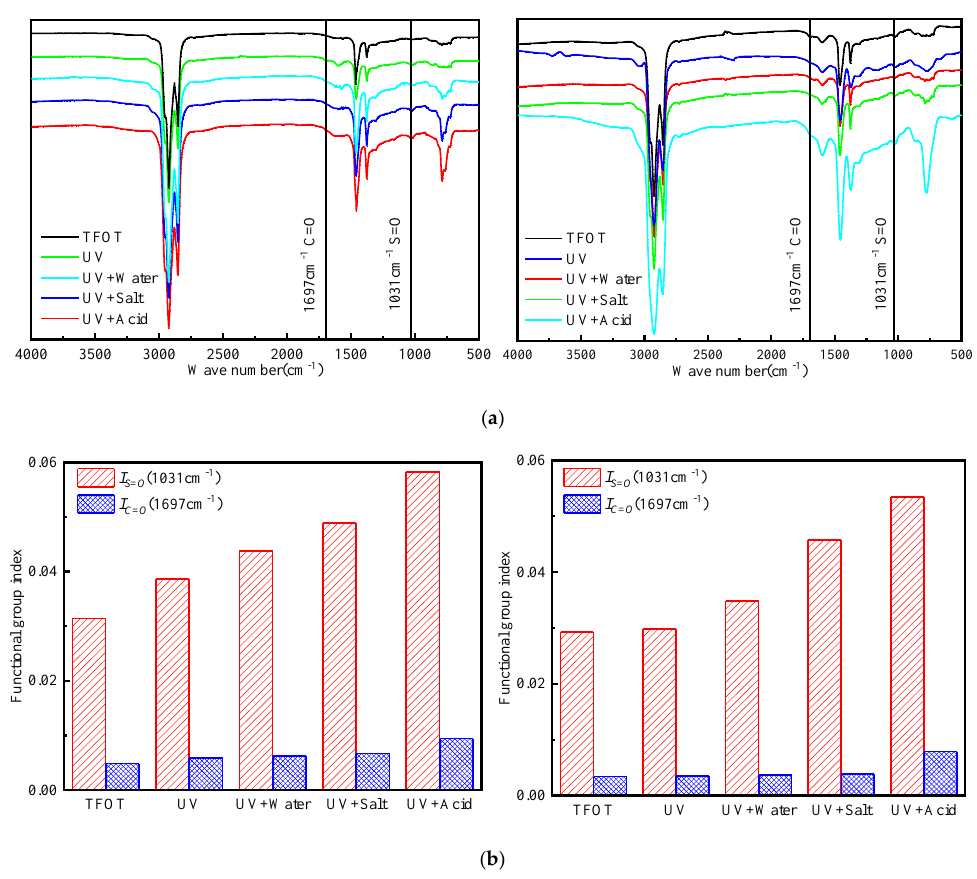
Figure 8. ( a ) Infrared spectra of base asphalt (left) and rubber asphalt (right) under different environmental conditions. ( b ) Functional group index of base asphalt (left) and rubber asphalt (right) under different environmental conditions.